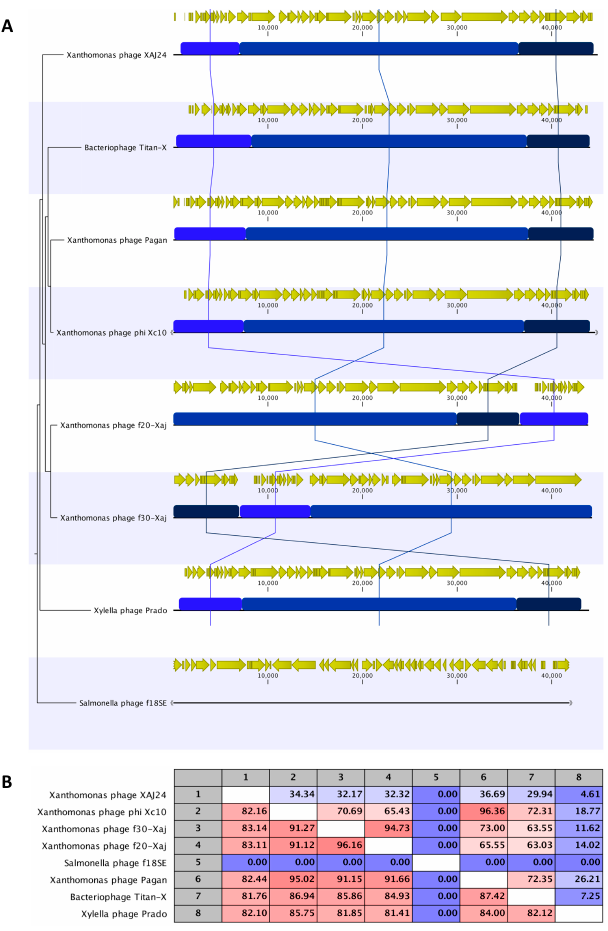
Figure 6. Genomic comparison at the nucleotide level of f 20-Xaj and f 30-Xaj genome to the other representative phages from the closest genus Pradovirus . ( A ) Whole-genome pairwise comparison of the eight phages’ complete nucleotide sequences, visualized as a matrix with percent identity with CLC Main Workbench 7. ( B ) ANI analysis table of eight Pradovirus phages selected. The color gradient from blue to red shows the percentage of identity, from lowest to highest, that each pair of phage genomes shares.